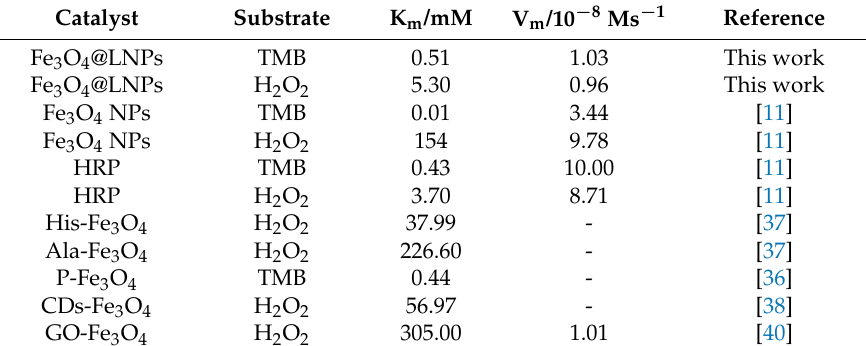
Figure 9. The steady-state dynamic analysis and catalytic mechanism of Fe 3 O 4 @LNPs: the Michaelis-Menten curves ( A and B ) and the double reciprocal plots of the activity of Fe 3 O 4 @LNPs( C and D ). Table 1. Comparisons of K m and V m among Fe 3 O 4 @LNPs, Fe 3 O 4 NPs, and Table 1. Comparisons of K m and V m among Fe 3 O 4 @LNPs, Fe 3 O 4 NPs, and HRP.